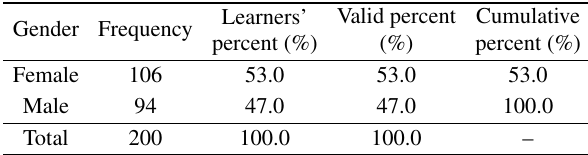
Table 1 Gender distribution of the